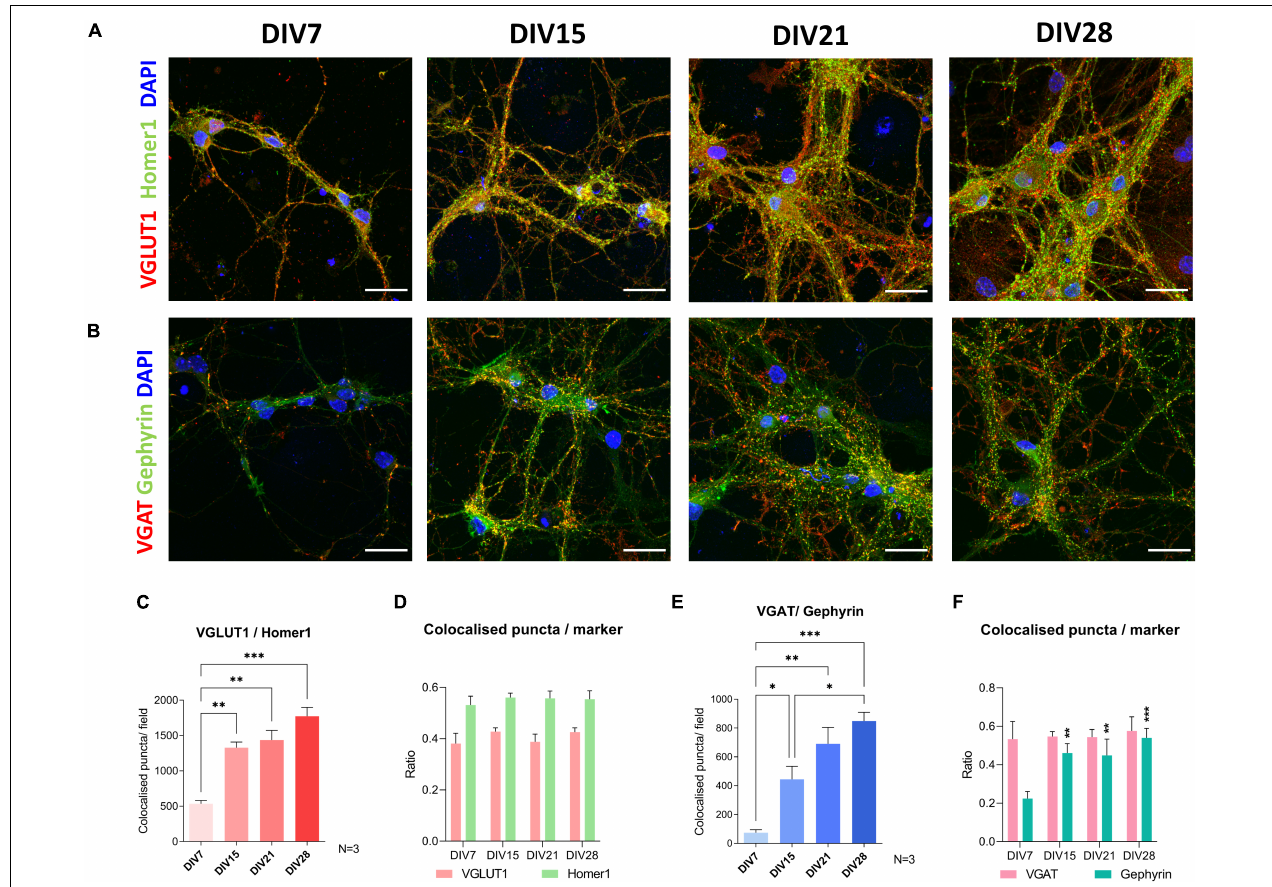
FIGURE 5 | Immunocytochemical analysis of synapse formation during cultivation of spinal cord culture. For excitatory synapse analysis, colocalization of VGLUT1 and Homer1 was examined (A,C,D) , while colocalization of synaptic markers VGAT and Gephyrin was used for analysis of inhibitory synapses (B,E,F) . Formation of new excitatory synapses was the most prominent between day in vitro (DIV) 7 and 15 (C) . A similar pattern was observed in colocalization analysis of inhibitory synapses (E) . VGLUT1, Homer1, and VGAT colocalization ratios were stable during cultivation (D,F) , while an increase of ratio of Gephyrin marked synapses that colocalized with VGAT occurred between DIV7 and DIV15 (F) . Scale bars: 25 µ m. Data are presented as means + SEM of N = 3 biological replicate cultures; ∗ p < 0.05, ∗∗ p < 0.01, ∗∗∗ p <